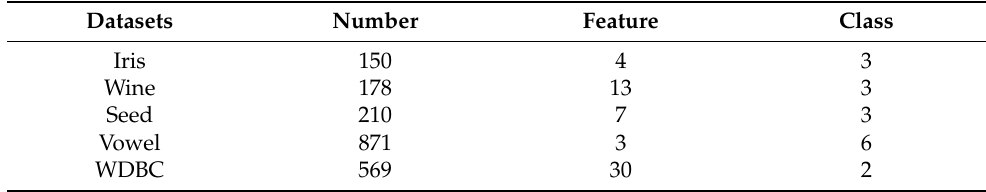
Table 3. Information about the UCI dataset.